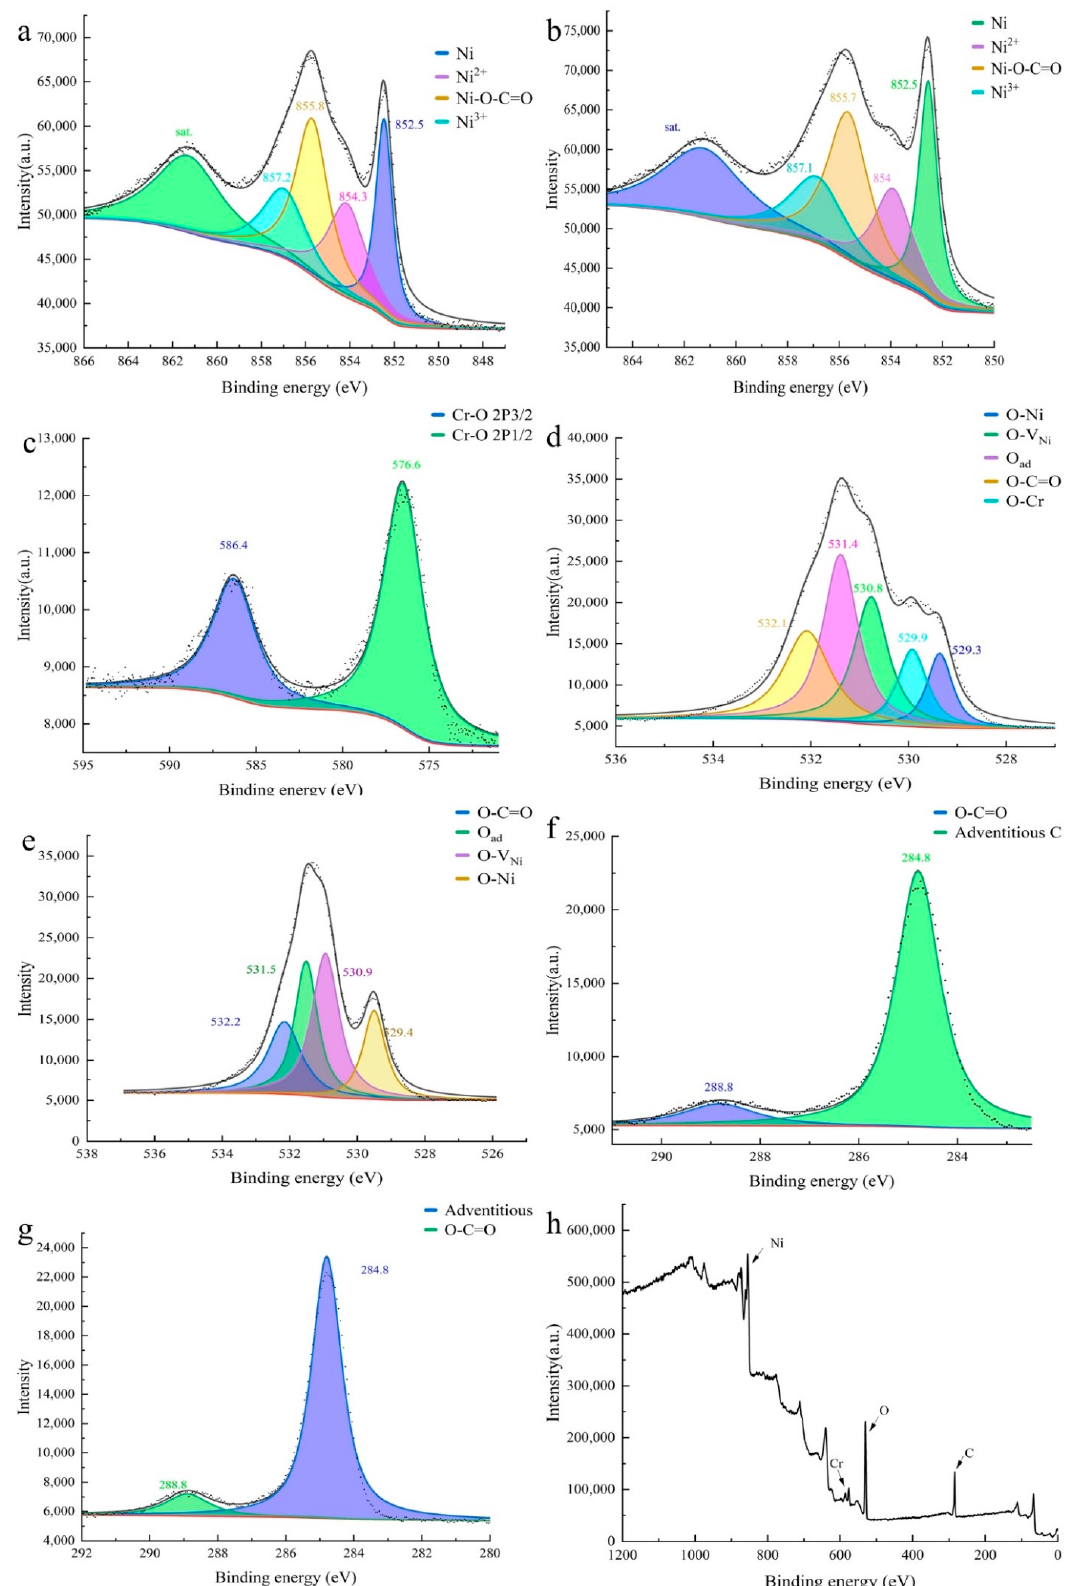
Figure 3. ( a , c , d , f ) High-resolution XPS spectra of the Ni 2p, Cr 2p, O1s and C 1s core levels for NiO-Cr-C/NF-3. ( b , e , g ) High-resolution XPS spectra of the Ni 2p, O 1s and C 1s core levels for NiO -C/NF. ( h ) XPS survey spectrum of